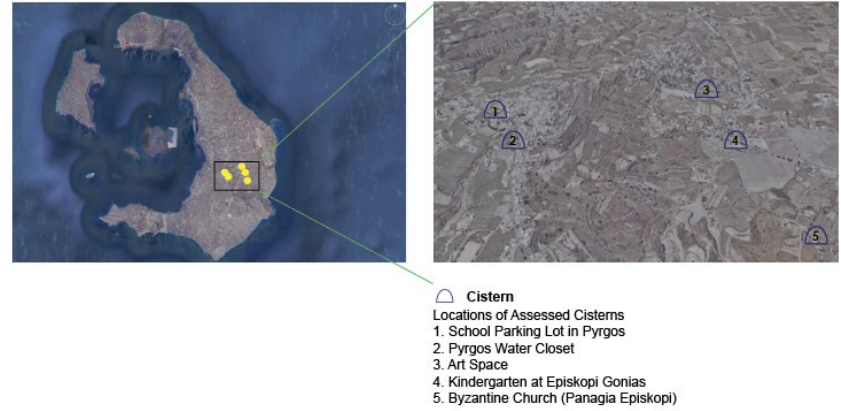
Figure 3. The centrally located cistern sites within Santorini.